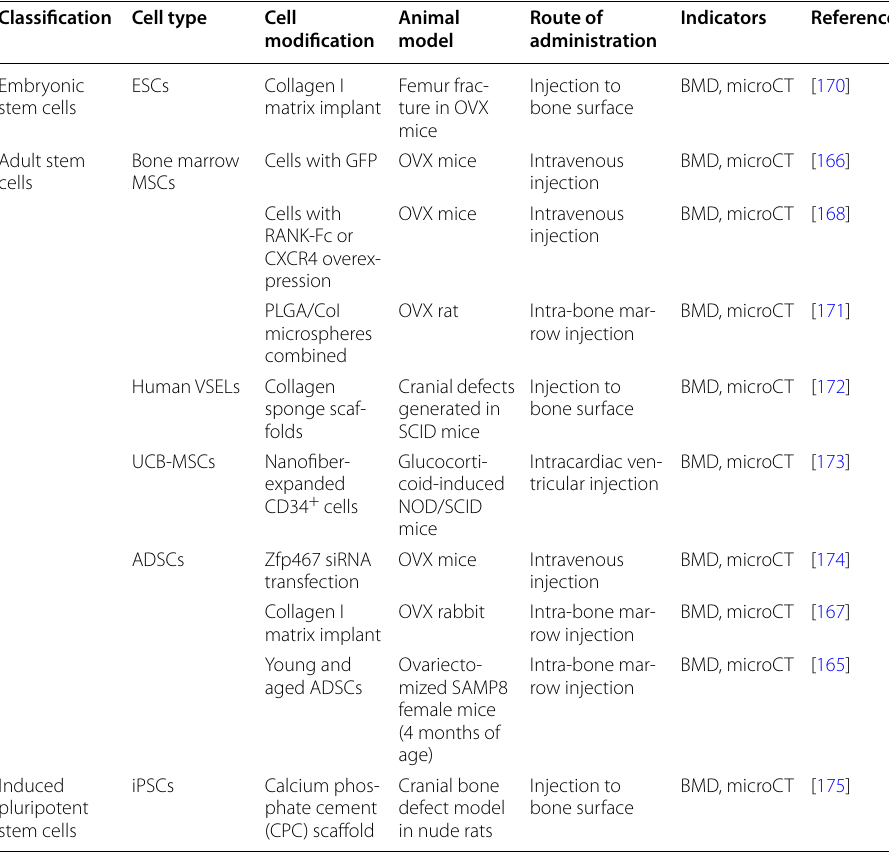
Table 3 In vivo animal experiments involving different types of stem cell for osteoporosis